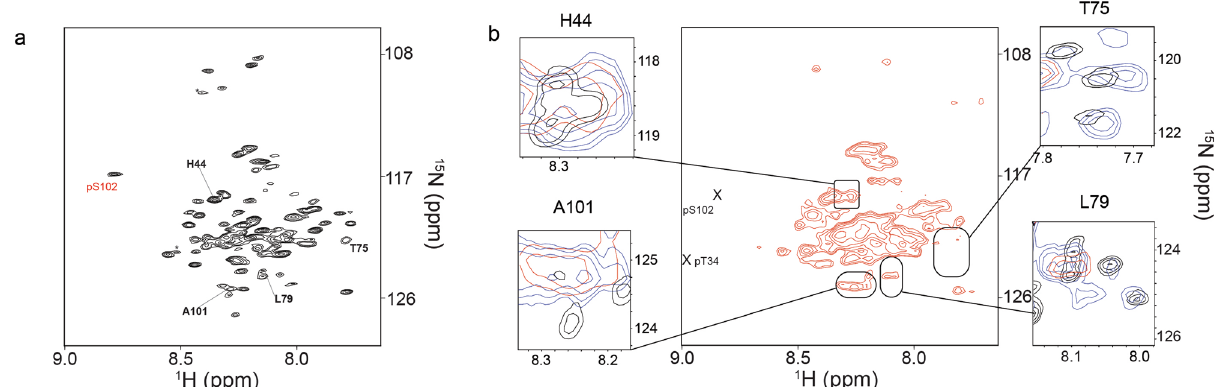
Fig. 4 Forskolin treatment results in broadening of the DARPP-32 1-122 in-cell NMR spectrum. a In vitro 1 H- 15 N HSQC spectrum of [ U - 15 N]-DARPP- 32 1-122 treated with CK2. The cross-peak associated with phosphorylated S102 is in red. Bold residues are the same as in the insets on the right. b In-cell 1 H- 15 N CRINEPT-HMQC-TROSY spectrum of [ U - 2 D, 15 N]-DARPP-32 1 H- 15 N HSQC 1-122 treated with Forskolin. Boxed regions show overlays from the in vitro spectrum of [ U - 15 N]-DARPP-32 1-122 (black) and the in-cell 1 H- 15 N CRINEPT-HMQC-TROSY spectrum of [ U - 2 D, 15 N]-DARPP-32 1-122 acquired in the absence (blue) and presence (red) (Fig. 4b boxed regions) often indicative of changes in quinary structure. The relevance of these changes was assessed by comparing the normalized cross-peak intensity ratios of [ U - 2 D, 15 N]-DARPP-32 1-122 from two biological replicate samples of VECT-transfected cells (Supplementary Fig. 6). About 90% of the cross-peak ratios were between 0.5 and 2 indicating a roughly two-fold variation in intensity (Supplementary Fig. 6). This level of biological variation, i.e., noise, precluded an accurate assess- ment of the location and extent of quinary structure changes due to Forskolin. Control experiments demonstrated that VECT- transfected cells maintained viability for at least the 90 min window required to prepare them for NMR spectroscopy. Beyond that, reduced intracellular oxygen and ATP were likely to cause collect the data, which may contribute to the spectral changes.